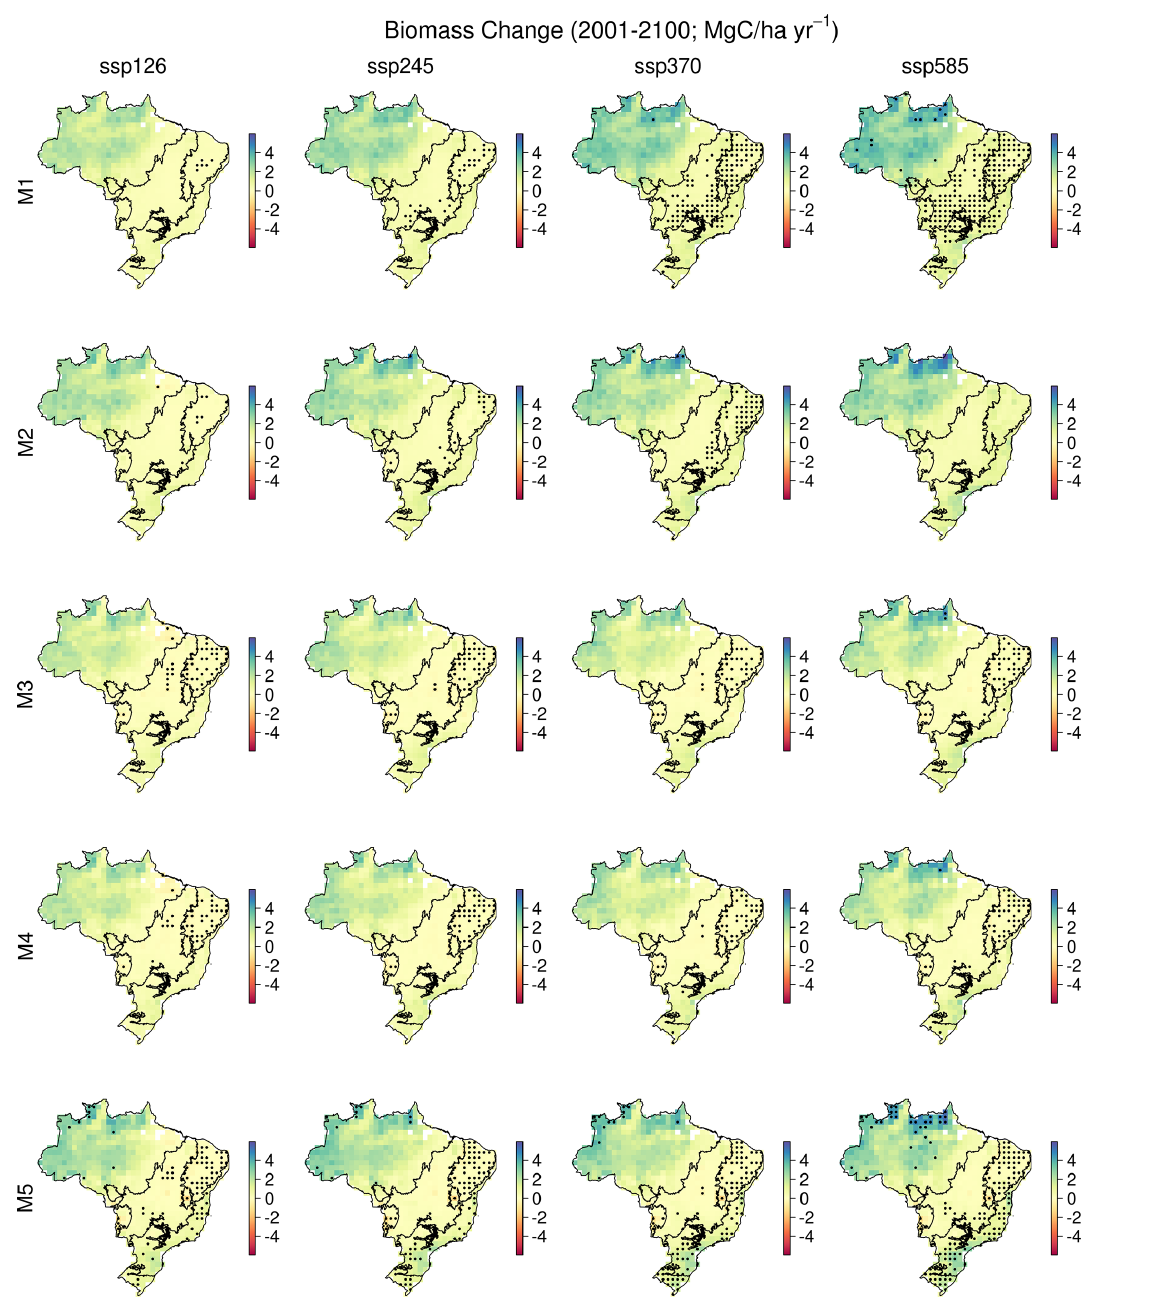
Figure A15. Maps of DALEC model estimates biomass (sum of labile, foliage, fine root and wood) change between 2001 and 2100. The mapped values are estimated from the pixel-level median estimates. Areas with biomass change with > 90% confidence are shown with